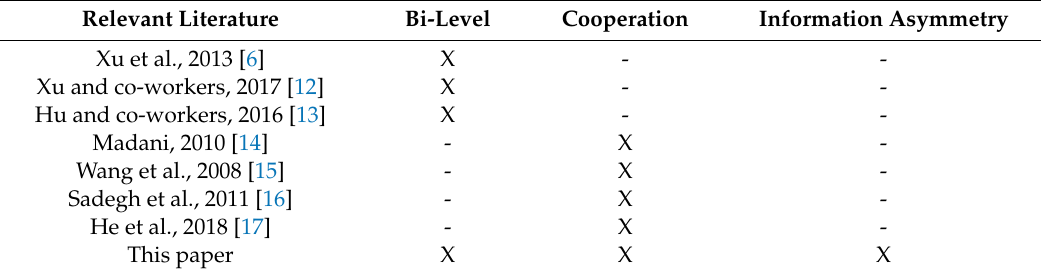
Table 1. Literature Review on Water